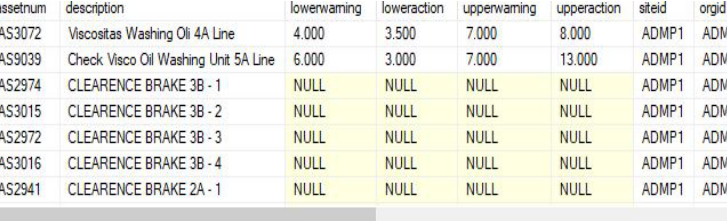
Fig. 4. Data before cleaning